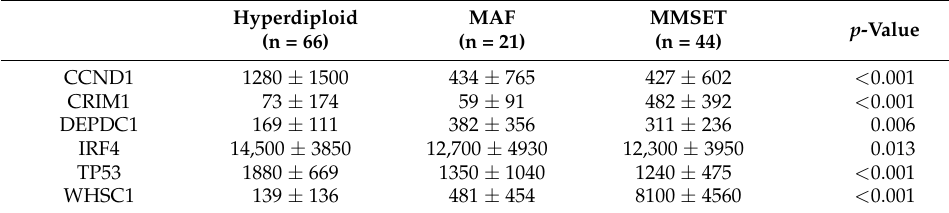
Table 8. Multiple Myeloma Data: gene expression average by molecular groups.